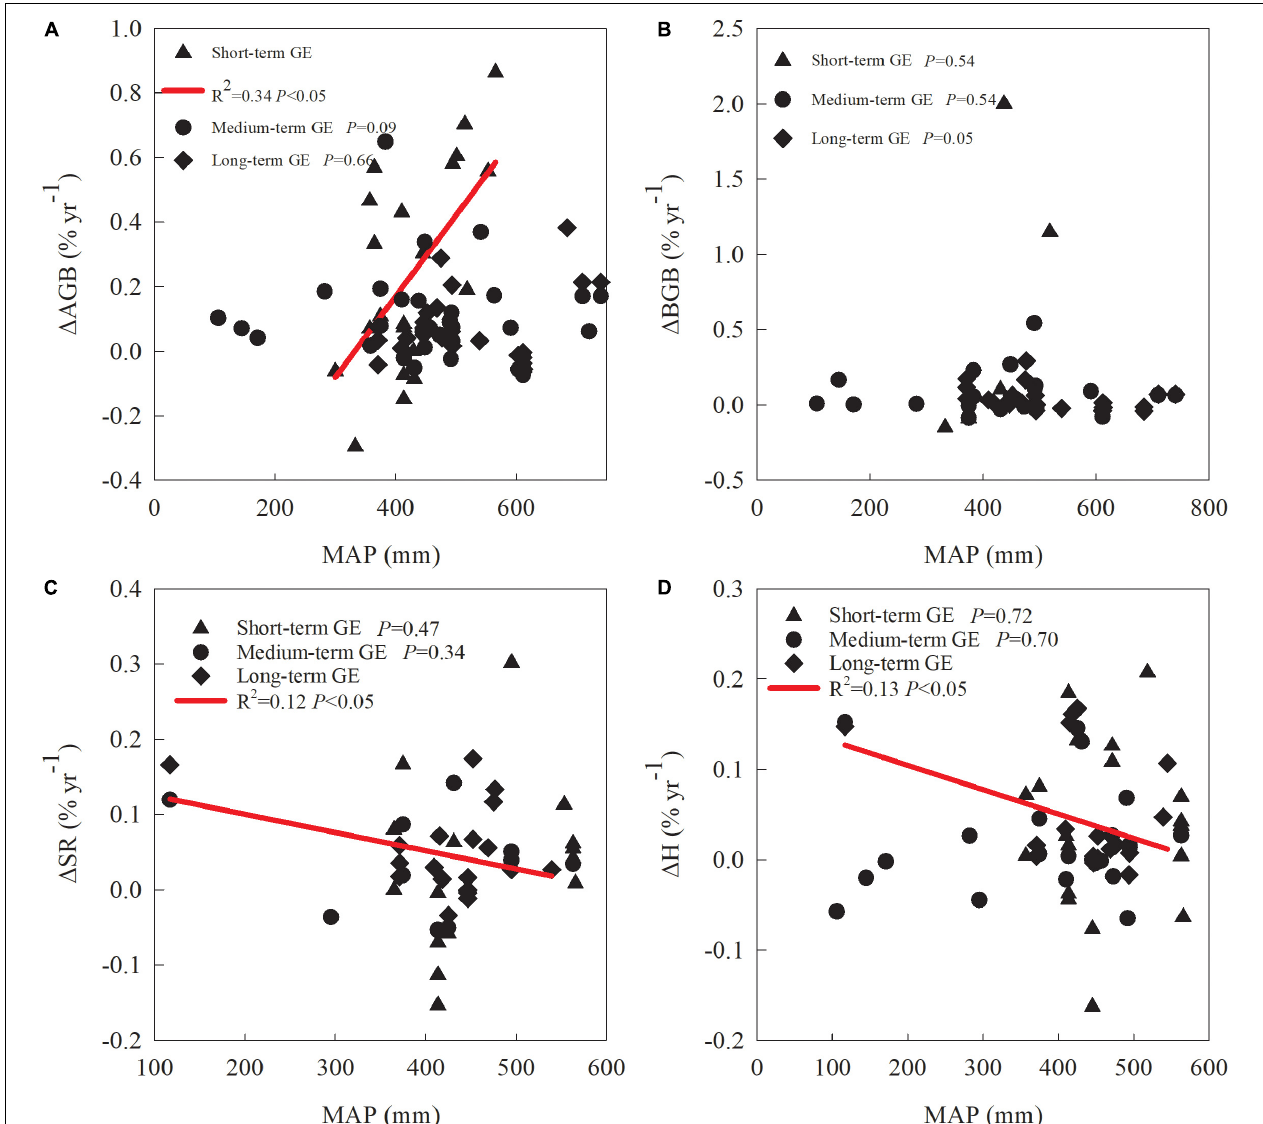
FIGURE 4 | Relationships of the percentage of mean annual changes in above- and belowground biomass, species richness, and Shannon-Wiener index with mean annual precipitation under different grazing exclusion durations (A–D) . AGB, BGB, SR, and H represent aboveground biomass, belowground biomass, species richness and Shannon-Wiener index,